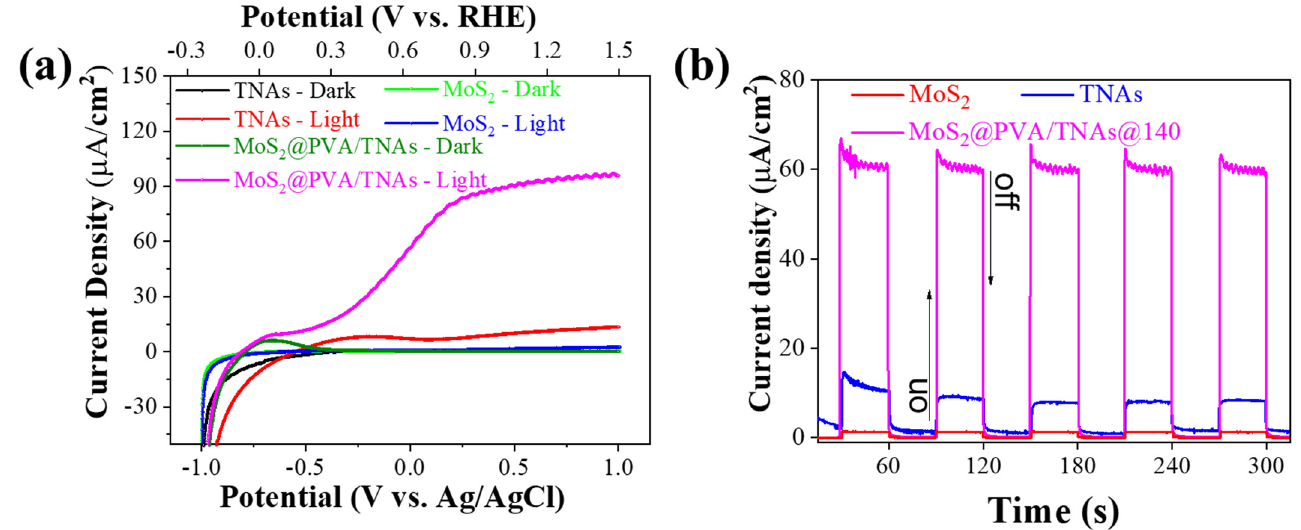
Figure 5. LSV curves of materials ( a ) and photoresponse ability of the materials with an applied potential at 0 V vs. Ag/AgCl ( b ).